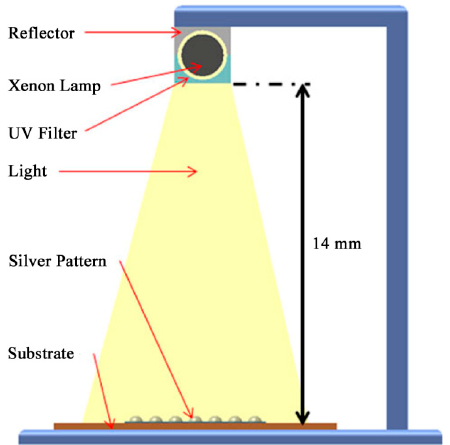
Figure 8. Schematic of intense pulsed light (IPL) sintering for Ag NPs based film using xenon flash irradiation. Reproduced with permission from [82]; Copyright 2011 irradiation. Reproduced with permission from [82]; Copyright 2011 Springer.